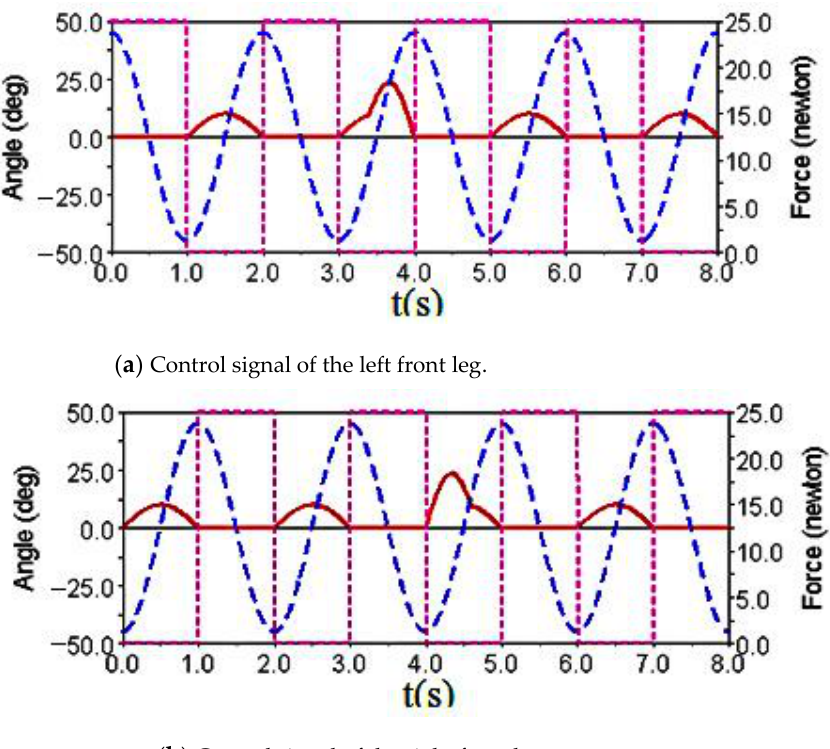
( b ) Control signal of the right front leg. Figure 10. Cont